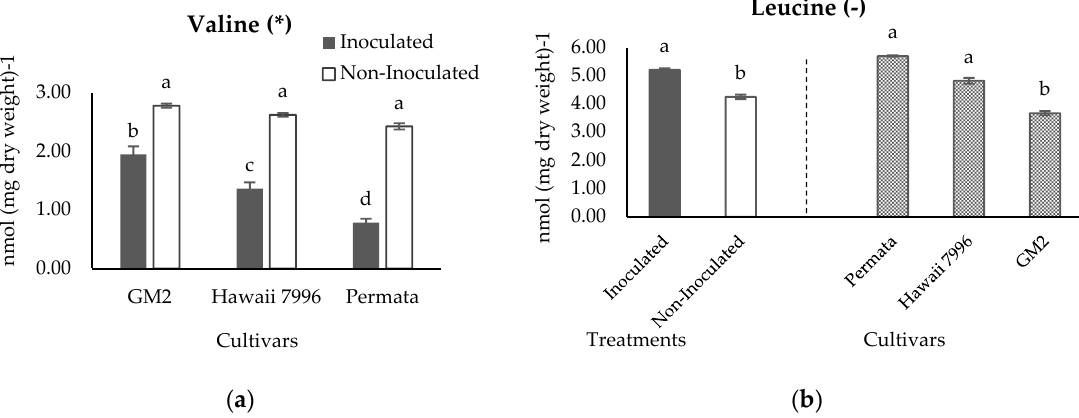
Figure 7. Concentration of Valine ( a ) and Leucine ( b ) in three cultivars tomatoes inoculated and non inoculated with Ralstonia solanacearum . Bars with the same letter in each group were not significantly different at p = 0.05 based on Tukey’s HSD tests. ( * ) indicates a significant interaction between treatments and cultivars; ( - ) indicates no significant interaction between treatments and cultivars; therefore, the histogram is separated between treatments and cultivars. Valine has the p cultivars = < 0.0001, p treatments = < 0.0001, p cultivars × treatments = 0.0016. Leucine has the p cultivars = 0.0005, p treatments = 0.0075, p cultivars × treatments =